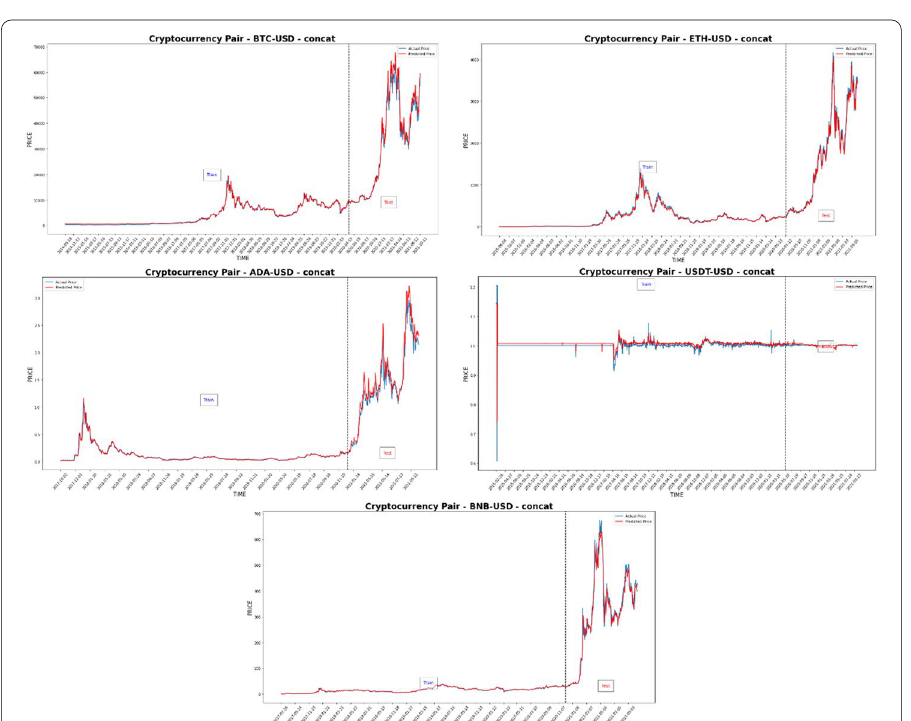
Fig.6 Prediction results for five cryptocurrencies using